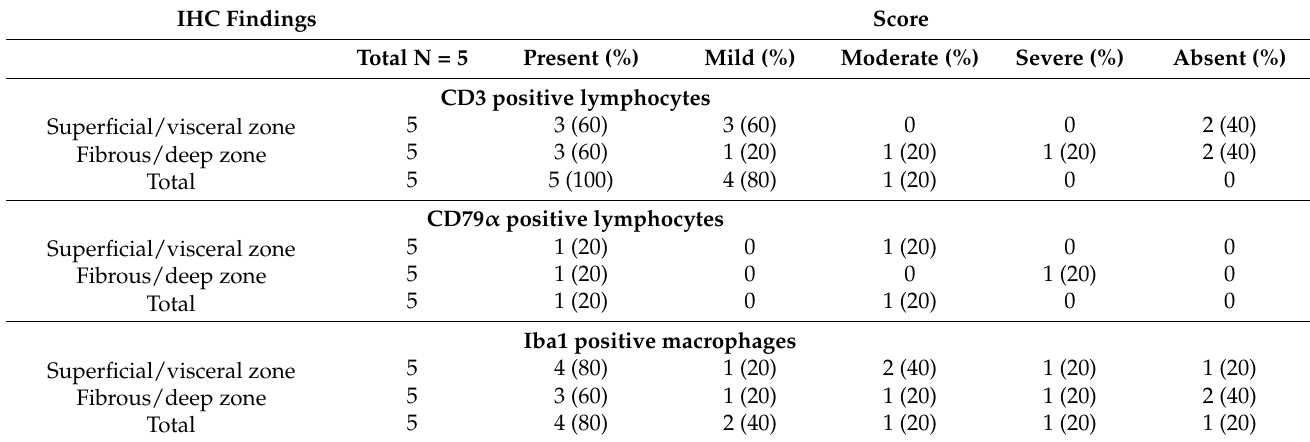
Table 5. Semiquantitative scoring of IHC findings in pericardial